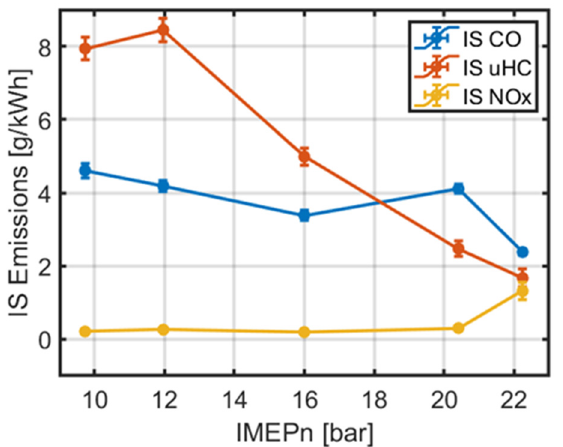
Figure 17. Indicated specific emissions of CO (IS CO), IS uHC, and IS NOx vs. net indication mean effective pressure (IMEPn).